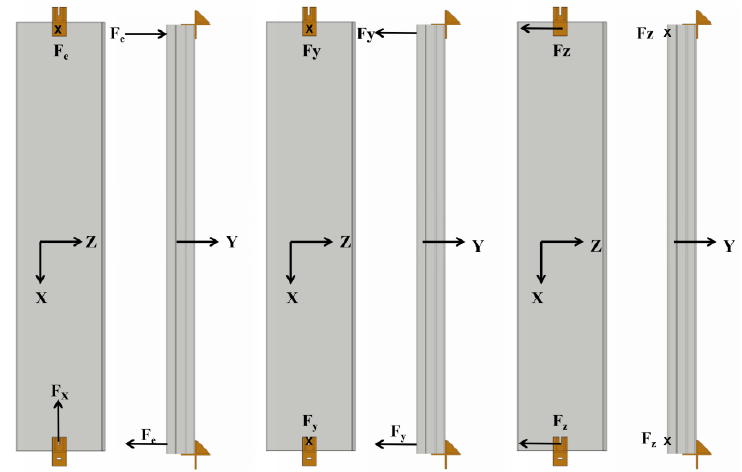
Figure 5. Force diagrams of NEDC and AAC wall panel.